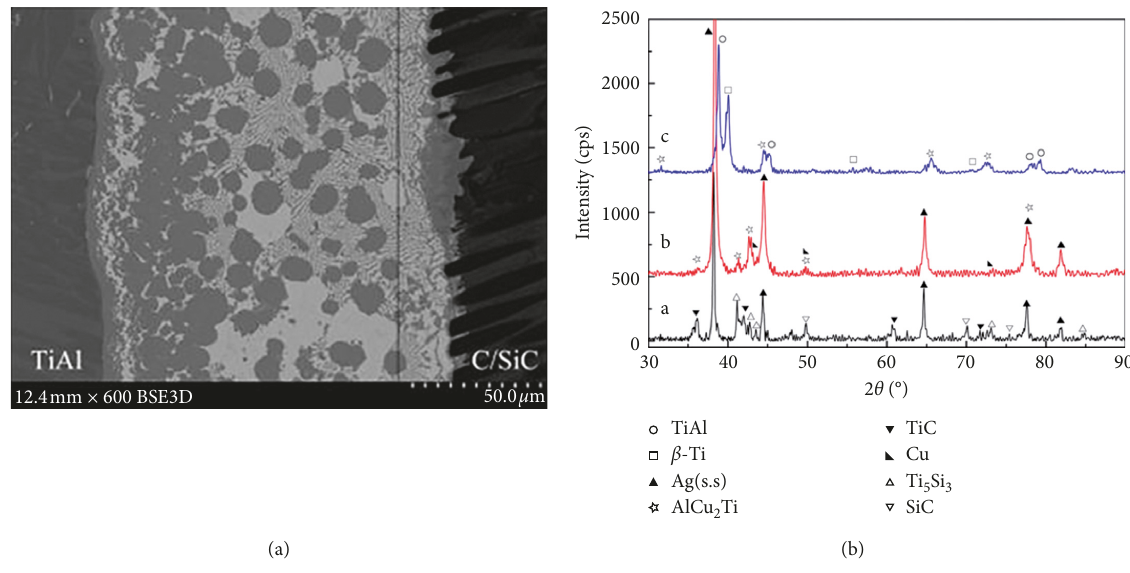
Figure 8: (a) Microstructures and (b) XRD patterns of the joint from C/SiC composites to TiAl brazed at 900 ° C for 10min [72]. Table 6: Brazing of C f /SiC composites to metals with low-temperature fillers.